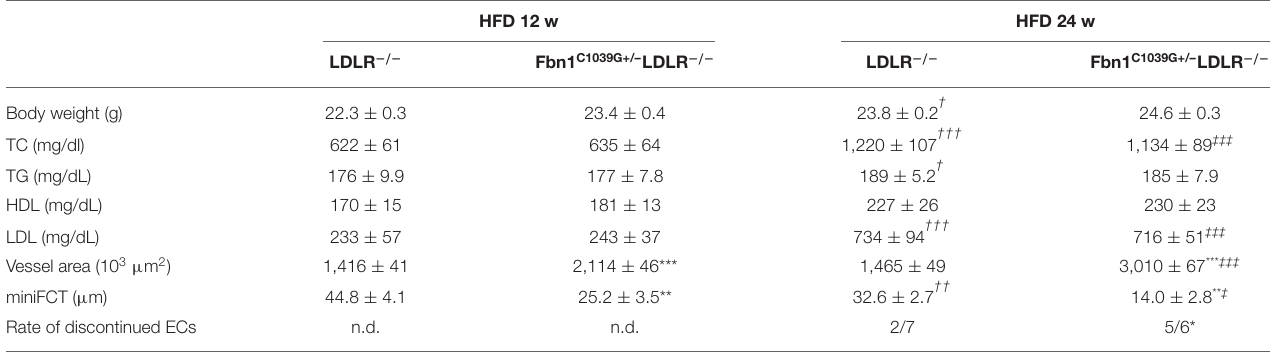
TABLE 1 | Characteristics of Fbn1 C1039G + / − LDLR − / − and LDLR − / − mice after 12 or 24 weeks on HFD.